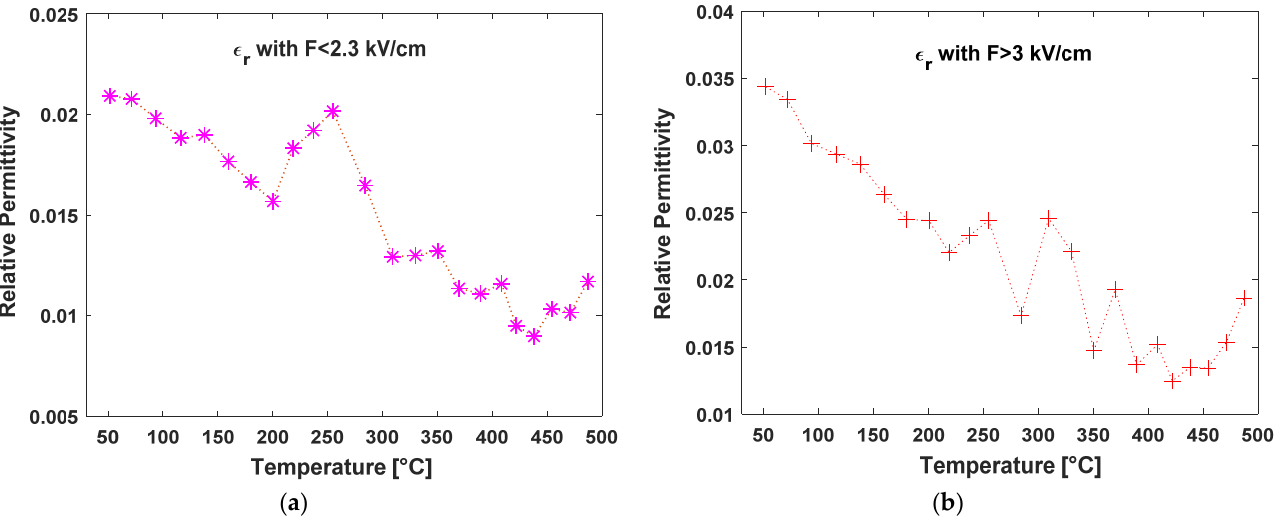
Figure 8. Relative Dielectric Permittivity as extracted by the I/V curves reported in Figure 6. ( a ) Extraction of parameter with V < 230 V; ( b ) Extraction of parameter with V > 300 V.